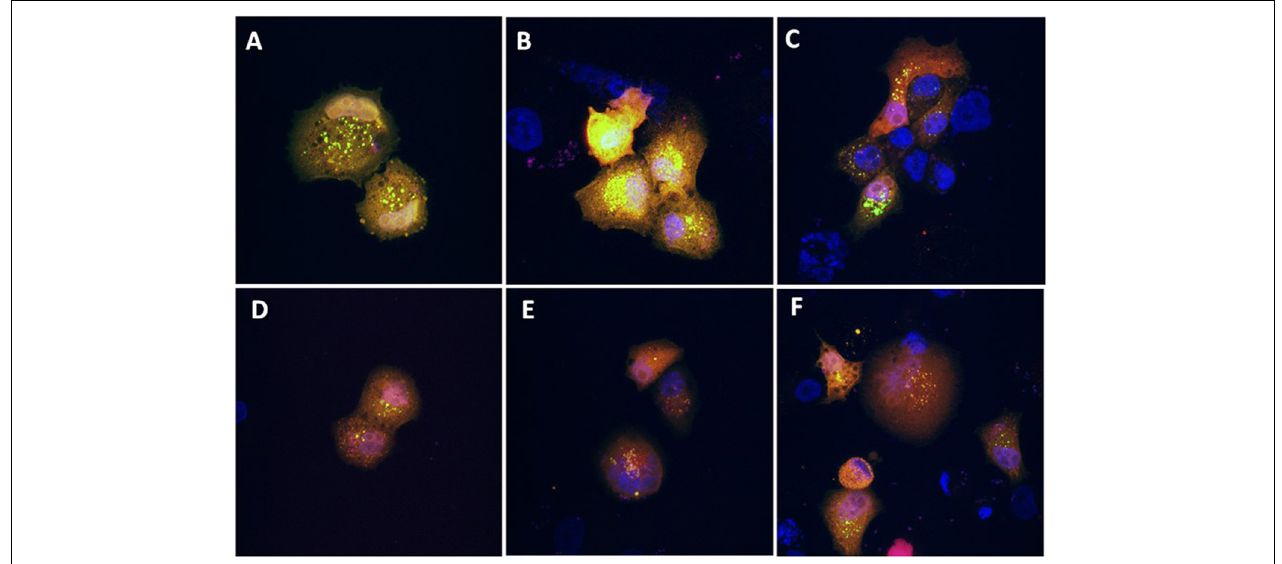
FIGURE 6 | Evaluation of the effect of TGM4 on autophagic flux. Representative confocal microscopy images (630 × ) of PANC-1 cells transfected with the ptfLC3 (LC3-RFP-GFP) plasmid and incubated with vehicle (A–C) or TGM4 35 µ M (D–F) for 48 h. Blue fluorescent signal (DAPI) marks the nucleus, whereas red and green signals represent LC3-B. After fusion of the autophagosome with lysosomes, green signal is degraded but not the red signal, due to differences in the isoelectric point between